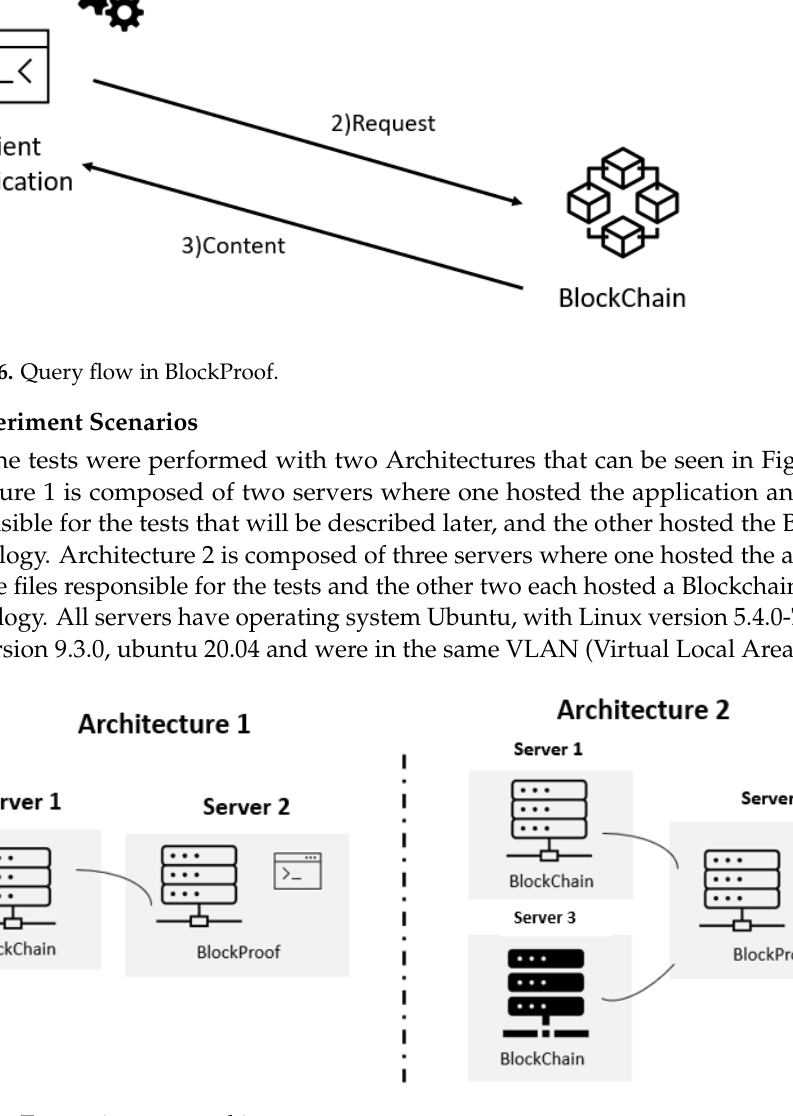
Figure 7. Test environment